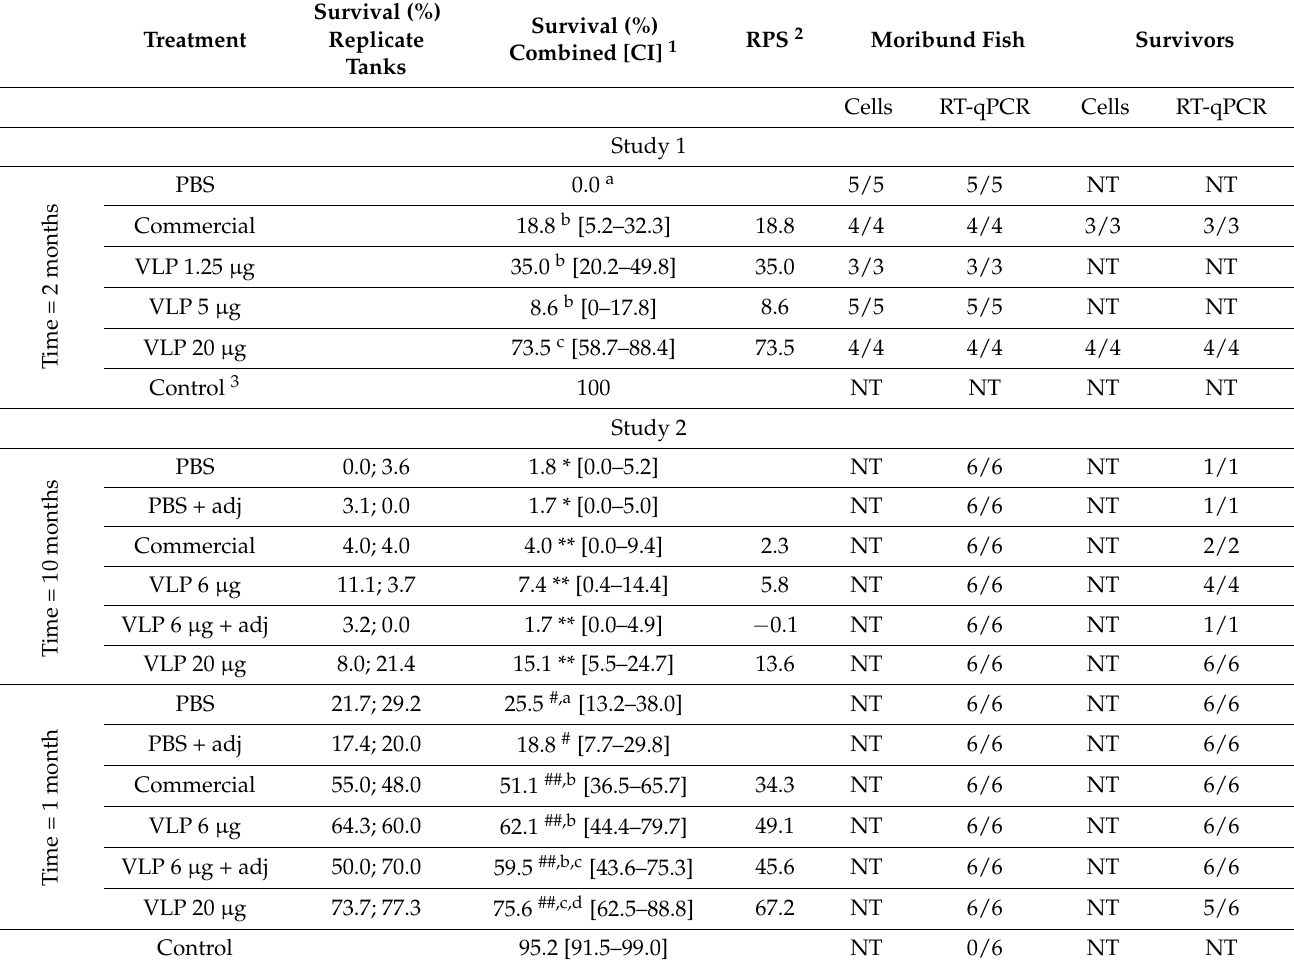
Table 3. Survival data and re-isolation/detection of